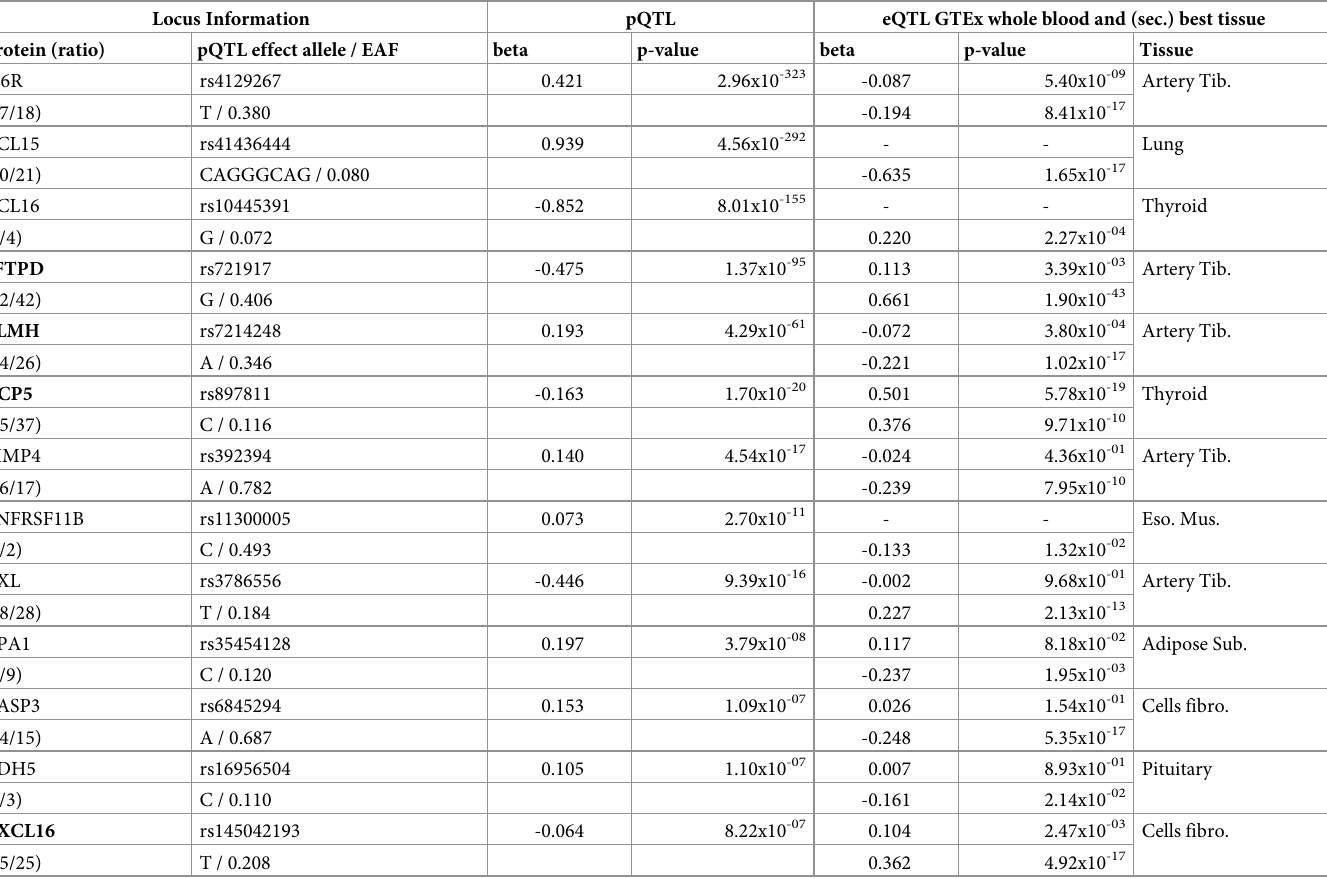
Table 2. Comparison of effect direction of cis-pQTLs from our GWAS and cis-eQTLs from GTEx. Locus